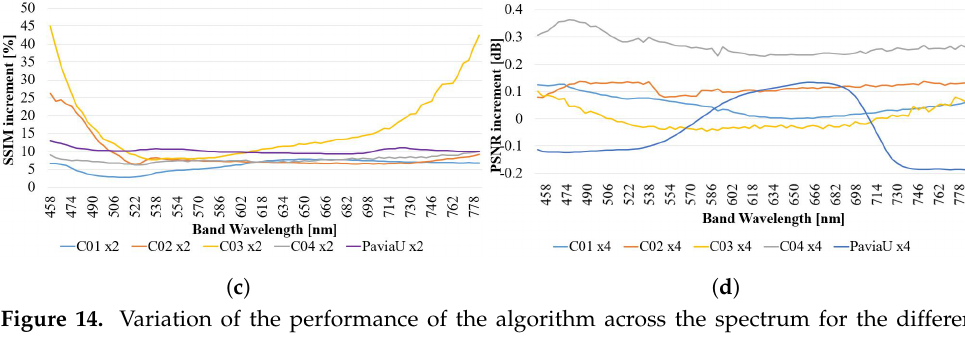
Figure 14. Variation of the performance of the algorithm across the spectrum for the different sequences: ( a ) SSIM for EF = 2 and N = 25, ( b ) PSNR for EF = 2 and N = 25, ( c ) SSIM for EF = 4 and N = 25, ( d ) PSNR for EF = 4 and N =